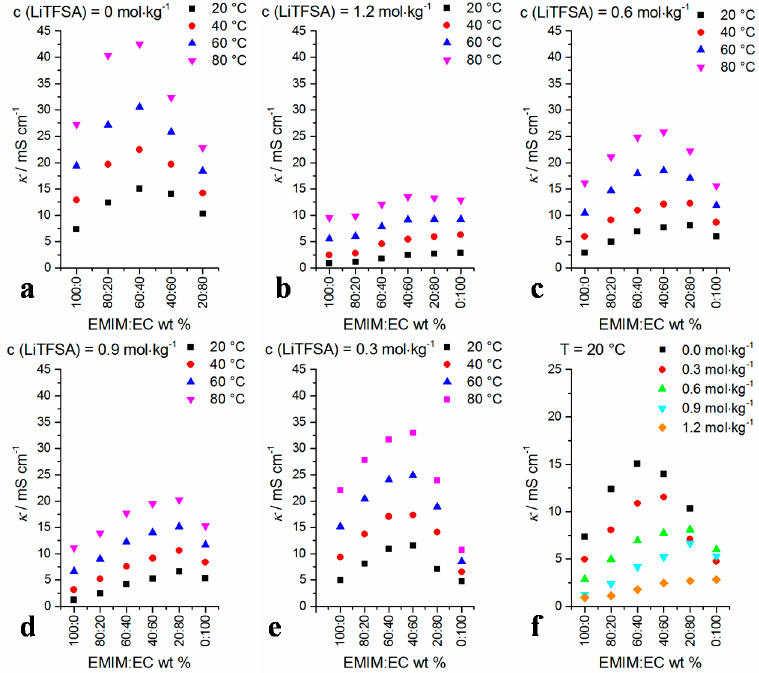
Figure 9. Temperature-dependent conductivity data of the mixtures vs. solvent ratio at selected Li-TFSA concentrations ( a – e ); In ( f ), the conductivity data at different Li-TFSA concentrations are compared at T = 20 °C.